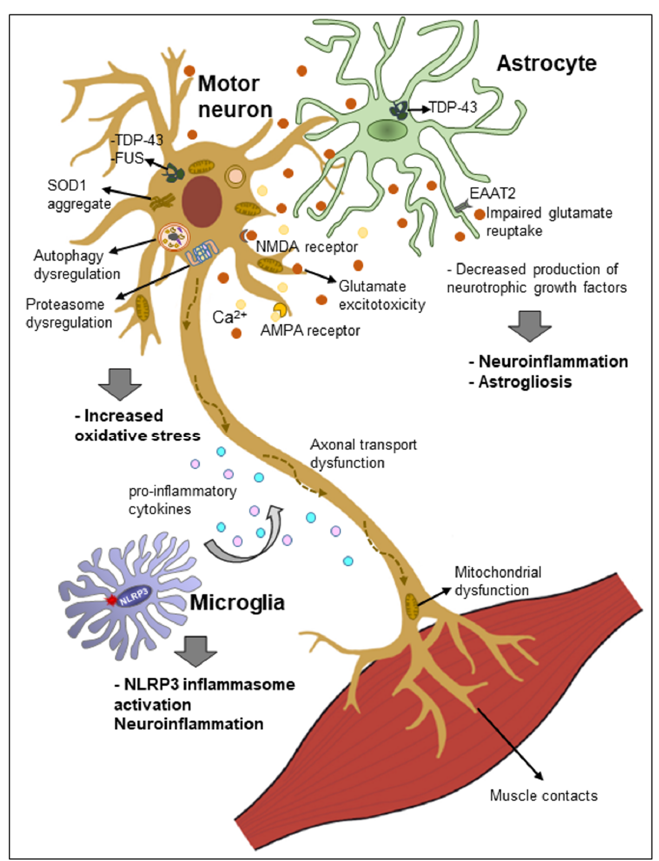
Figure 4. Proposed mechanisms of the pathogenesis of amyotrophic lateral sclerosis (ALS). The mechanisms underlying neurodegeneration in ALS are multifactorial and mediated through a complex interplay of molecular and genetic pathways. Specific pathways involved are increased generation of reactive oxygen species, glutamate excitotoxicity, mitochondrial dysfunction, axonal transport dysfunction and accumulation of cytoplasmic protein aggregates consisting of SOD1, TDP-43 and FUS. Activation of astrocytes and microglia results in secretion of proinflammatory cytokines, leading to neuroinflammation and motor neuron degeneration.